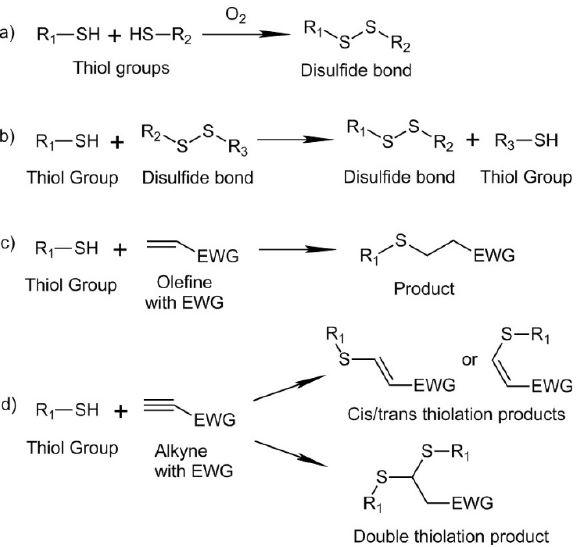
Figure 5. Thiol Chemistry: ( a ) Disulfide formation through oxidation reaction, ( b ) disulfide-exchange reaction, ( c ) Michael addition reaction, and ( d ) thiol–yne addition reaction.